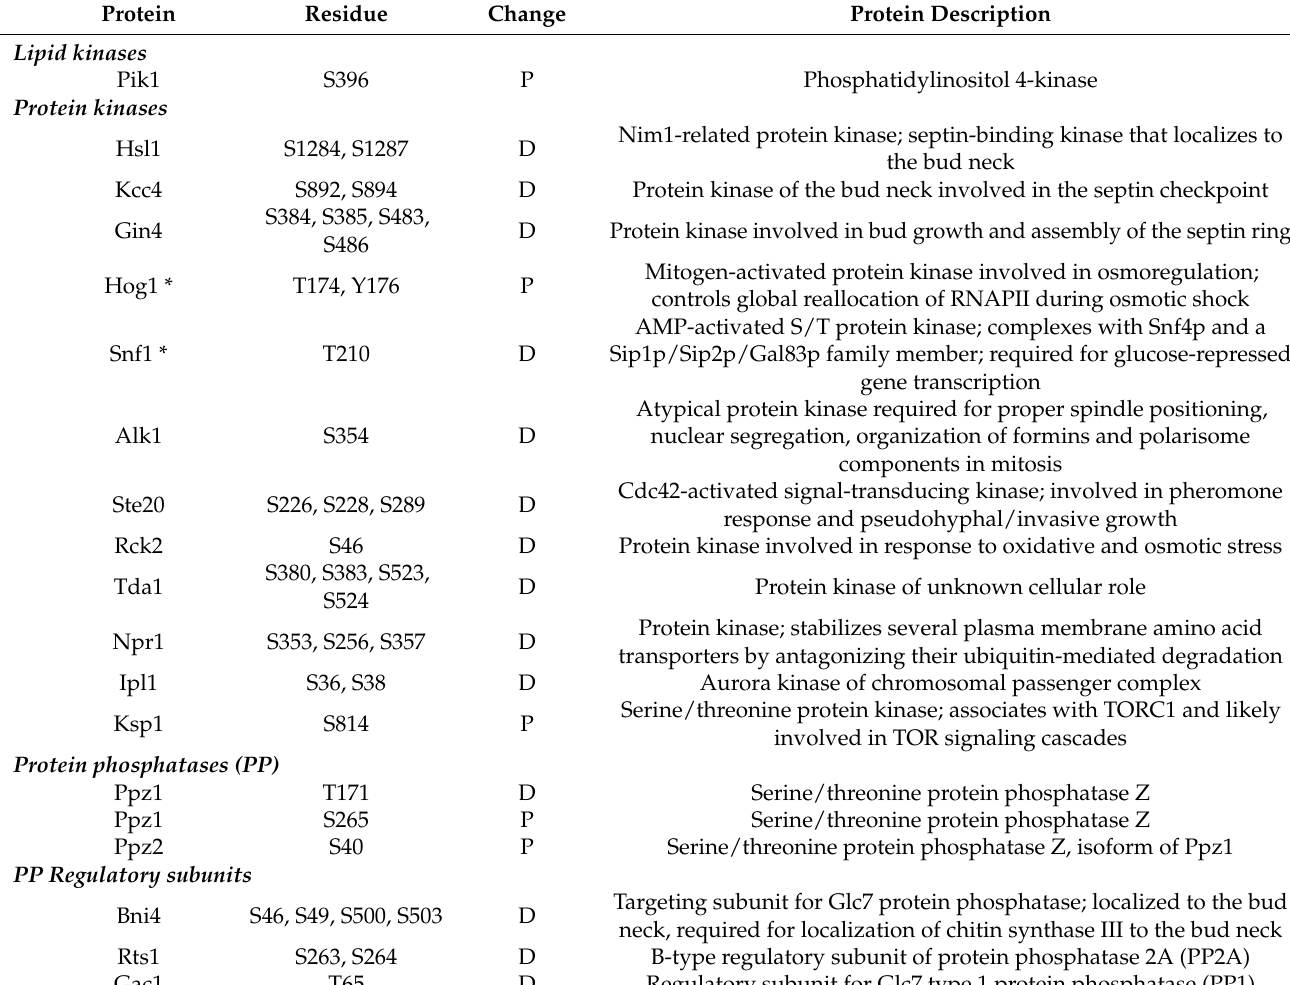
Table 3. Residues found phosphorylated or dephosphorylated in kinases and phosphatases involved in cell signaling. Asterisks denote proteins that were not identified as significantly modified in the phosphoproteomic experiments but whose changes were confirmed by alternative experimental methods [29]. P, phosphorylated; D,